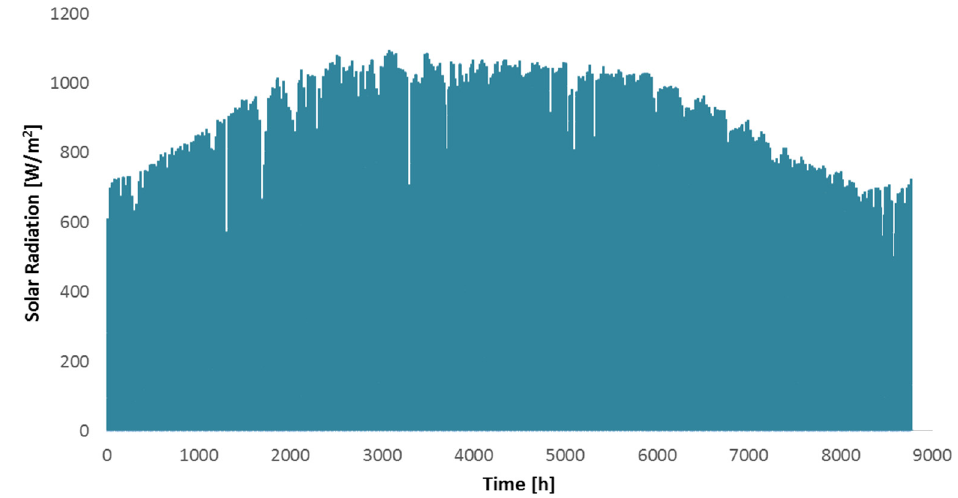
Figure 2. Load profile of the studied area.